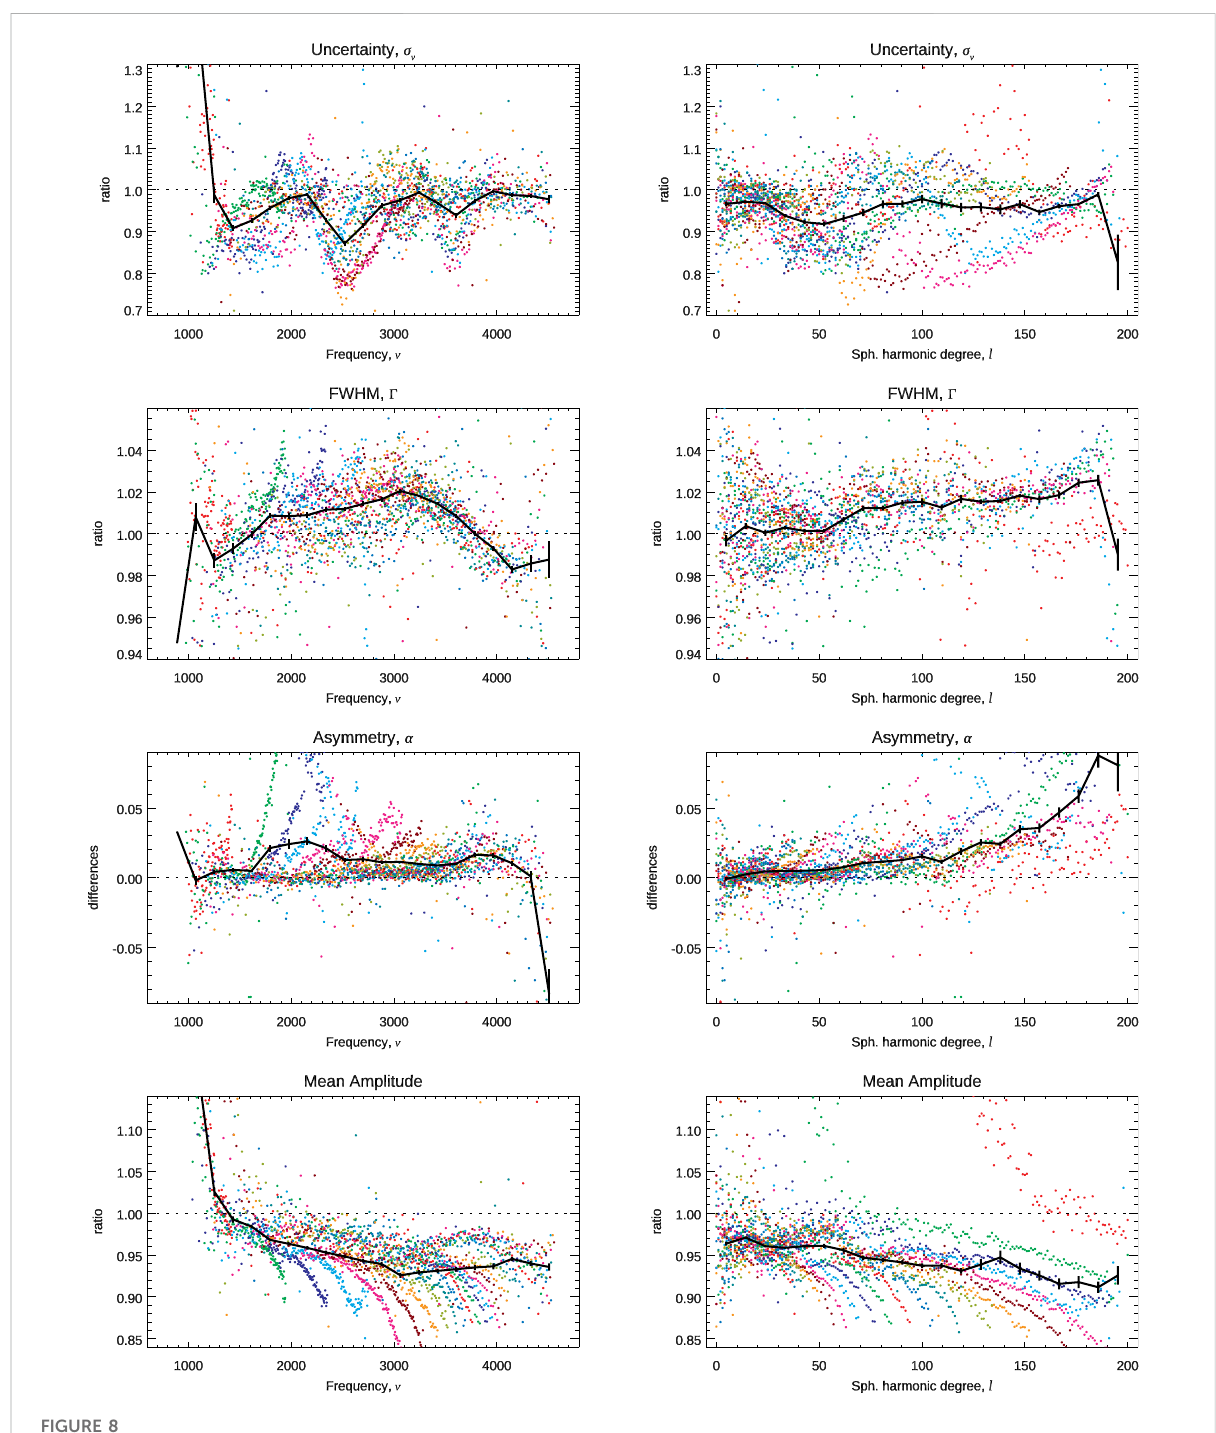
FIGURE 8 Comparison of mode characteristics, σ ] , Γ , α , and (cid:2) A ratios or differences, when fi tting and then averaging two abutting 4,608-day-long time series to the corresponding 9,216-day-long time series, using the same leakage